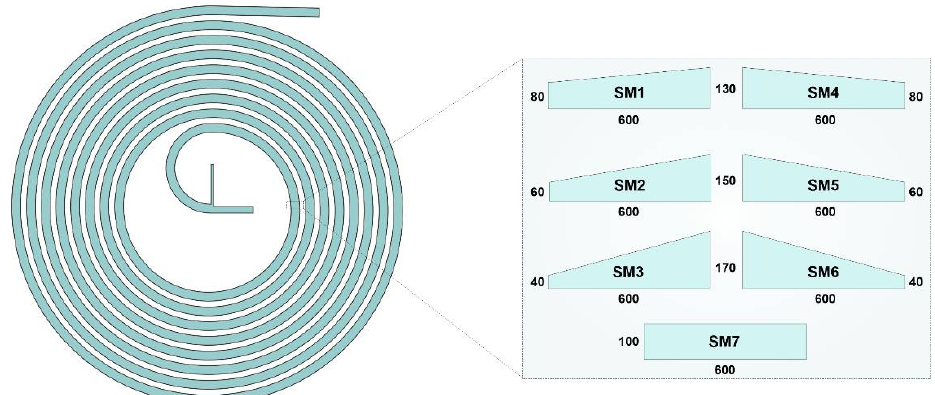
Figure 1. Schematic of the microchannel and the proposed cross-sections along with the applied boundary conditions. SM1 to SM3 in the left column are trapezoidal cross-sections before flipping when the outer wall is shorter, while SM4 to SM6 on the right column refer to mirrored ones with shorter inner walls. The cross-section hydraulic diameter and total fluid volume capacity of the micromixer are kept equal in all cases. All dimensions are in micrometers.